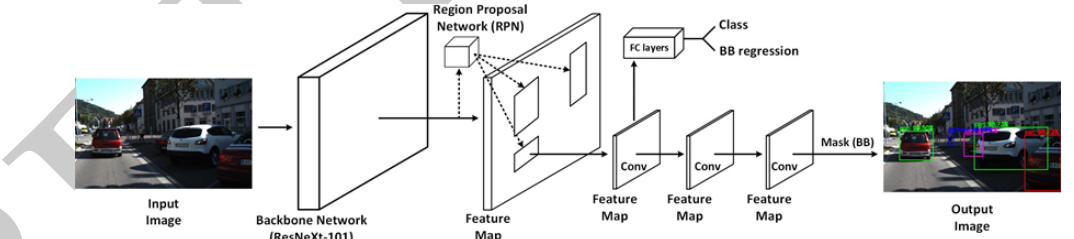
Figure 3. The architecture of the Mask Region-based Convolutional Neural Networks (Mask R-CNN) [27].